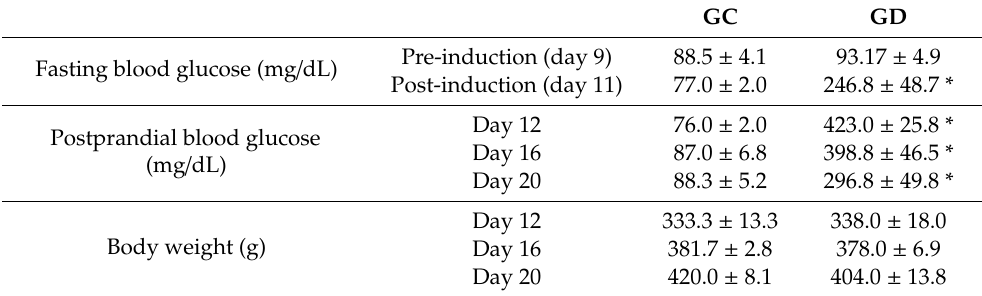
Table 1. Glucose levels and body weight of control and diabetic dams during the